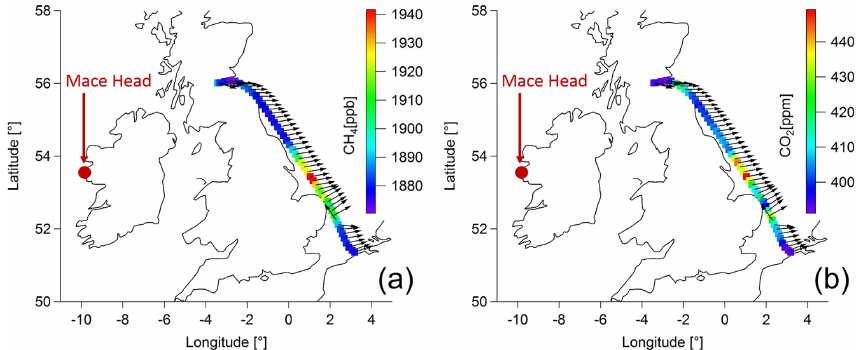
Figure 3. Half-hourly averages of (a) CH 4 and (b) CO 2 mole fractions measured on board the freight ferry during the south-bound journey on 29–30 July 2014. The arrows represent wind